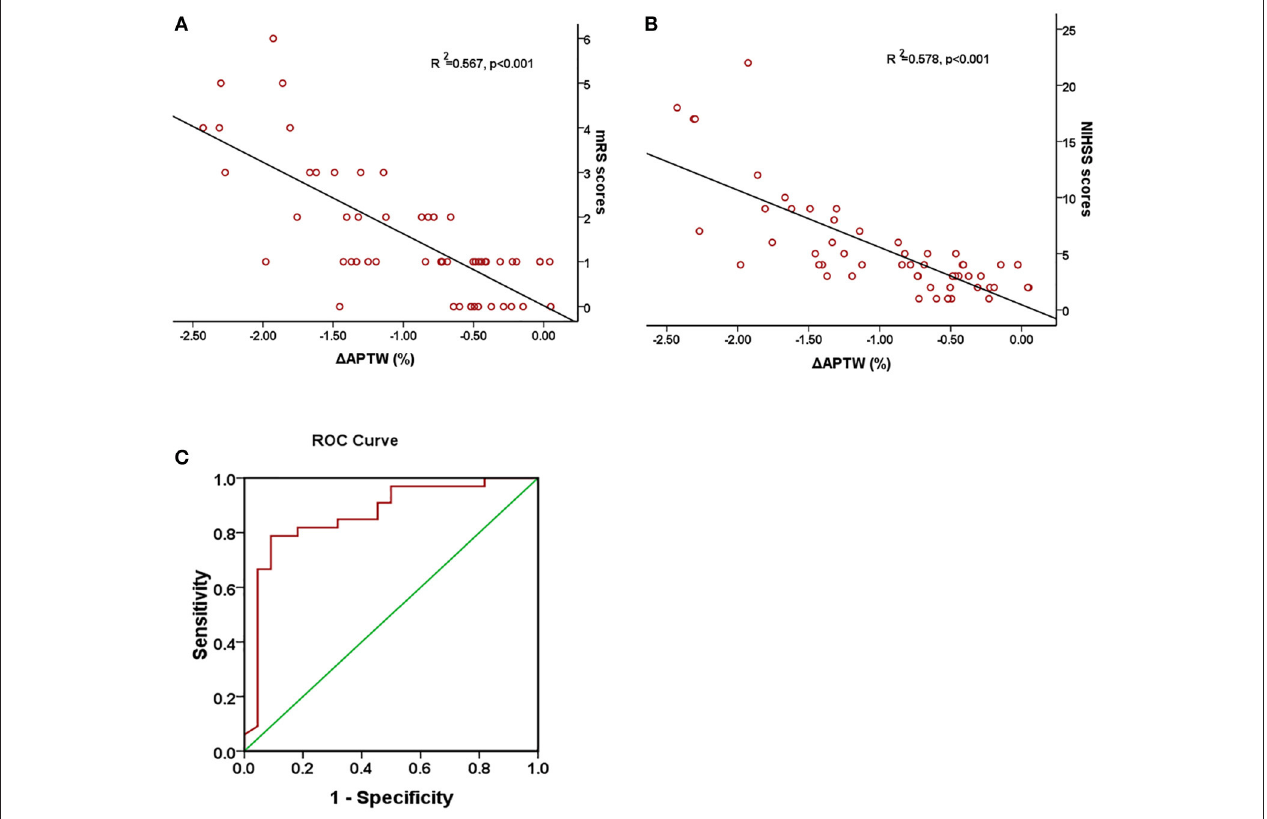
FIGURE 4 | Association between 1 APTW and NIHSS score and 90-day mRS score. Pearson regression test showed a good correlation between 90-day mRS score (A) and NIHSS score (B) with 1 APTW. Receiver operating characteristic (ROC) curves of 1 APTW to predict good/poor outcome (C) . The area under the curve is